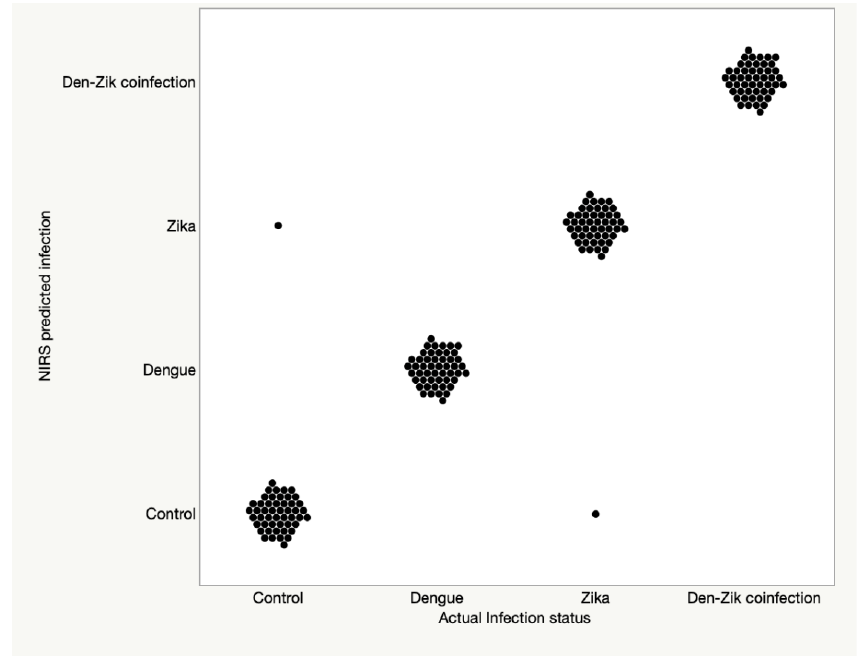
Figure 3. The predictive accuracy of NIRS for samples that were used for training and validation of the ANN model.